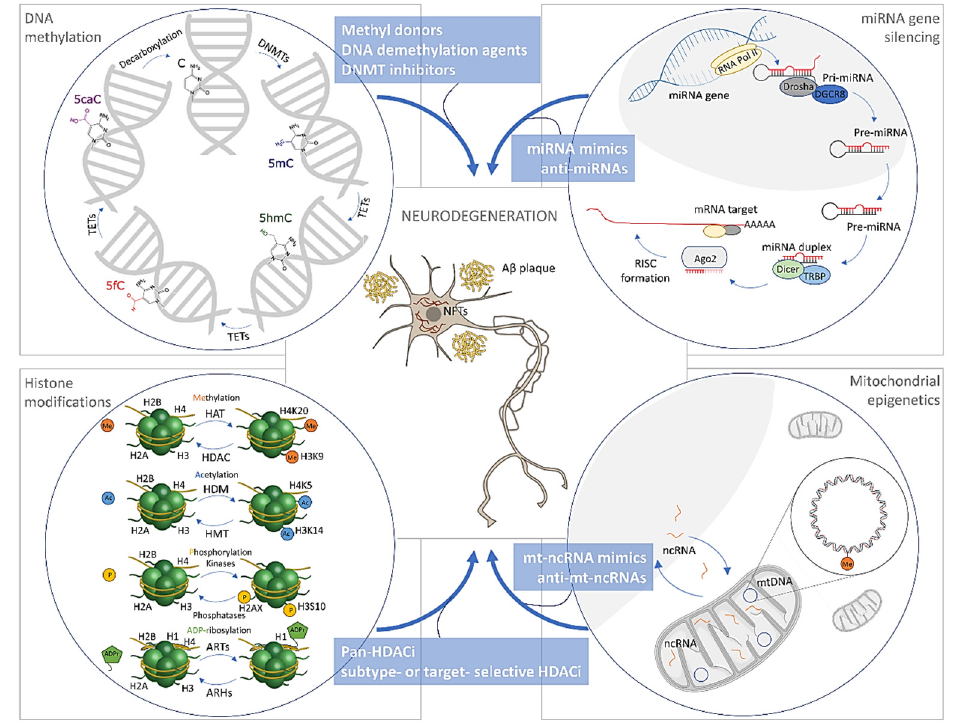
Figure 1. Epigenetic mechanisms in Alzheimer’s disease (AD) and possible treatment opportunities. 5caC—5-carboxyl cytosine; 5fC—5-formylcytosine; 5hmC—5-hydroxymethyl cytosine; 5mC—5-methylcytosine; A β —amyloid β ; Ac—acetylation; Ago2—argonaute 2; ARHs—ADP-ribose hydro-